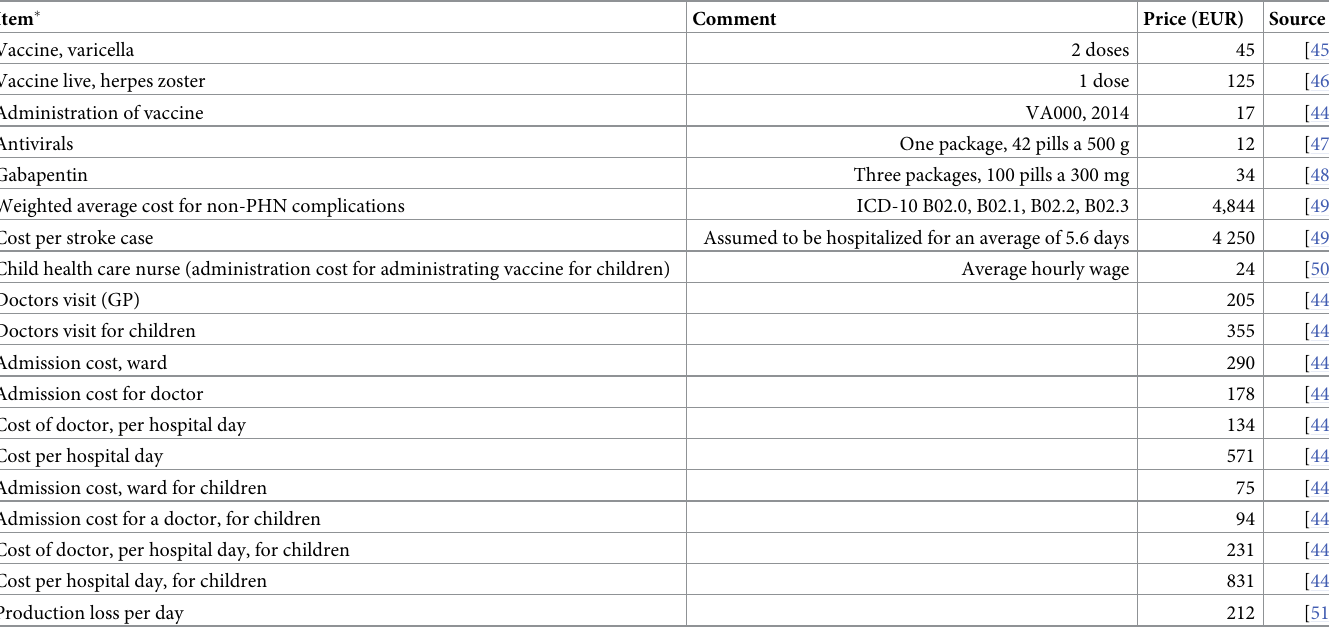
Table 2. Cost per item used in the health economic